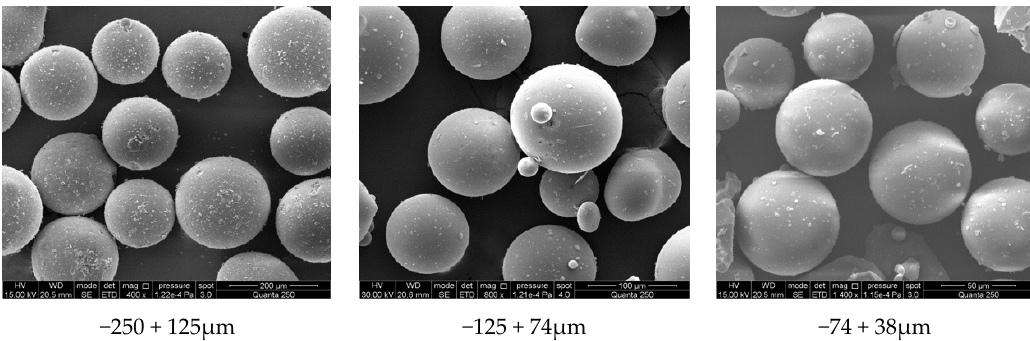
Figure 2. SEM micrographs of different glass microspheres.